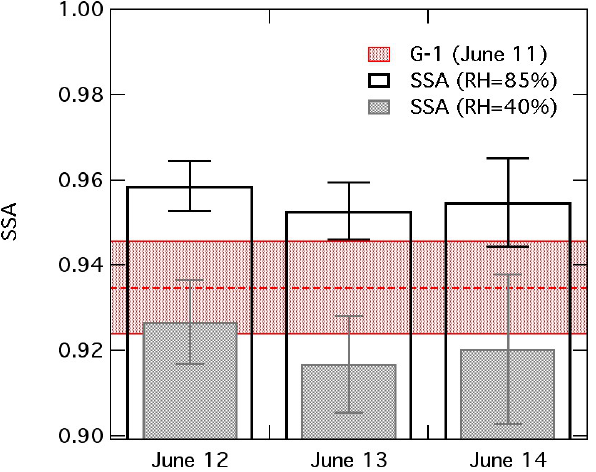
Fig. 4. Daily average mean surface SSA on 12 June through 14 June 2007 at the ACRF Central Facility for RH of 40% (grey), SSA for the same days for RH of 85% (black), and average SSA computed form G-1 flight leg on 11 June (dashed red line). Error bars for surface measurements indicate the standard deviation for that day, and red shading indicates the standard deviation of SSA measured by the